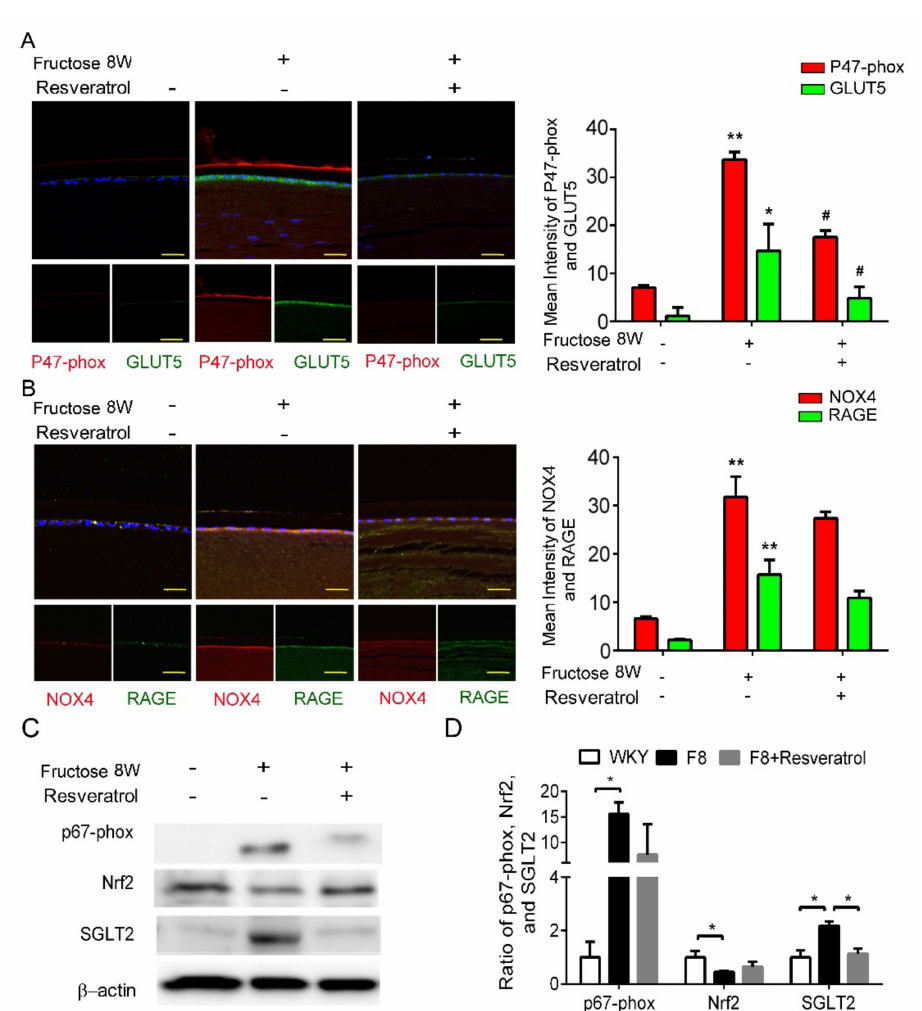
Figure 4. Resveratrol reduces fructose-induced NADPH oxidase subunit production mediated through a SGLT2 − dependent mechanism in the epithelial section of type 2 DM lens. ( A , B ) Repre- sentative images for GLUT5 − positive (green) and p47 − phox NOX4-positive (red) cells in the lens after resveratrol treatment, compared to no fructose group. Cell nuclei were counterstained in DAPI (blue). ( C , D ) Quantitative analysis demonstrated that SGLT2 and p67 − phox proteins‘ level were significantly decreased by resveratrol treatment. Values are presented as mean ± SEM ( n = 6 per group). Scale bar = 20 µ m. * p < 0.05 and ** p < 0.001; # p < 0.05 versus Fructose 8